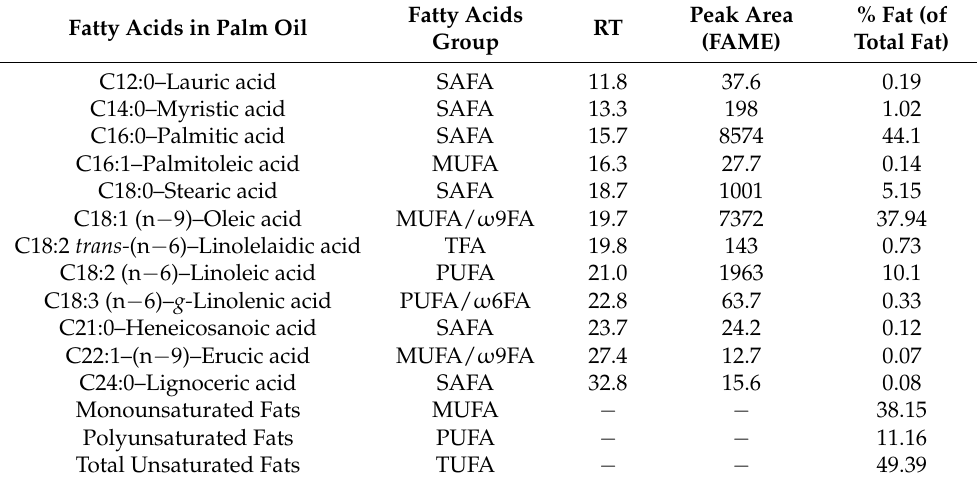
Table 3. Fatty acids with their relative percentage in the total fat of the crude palm oil. Fatty Acids in Palm Oil